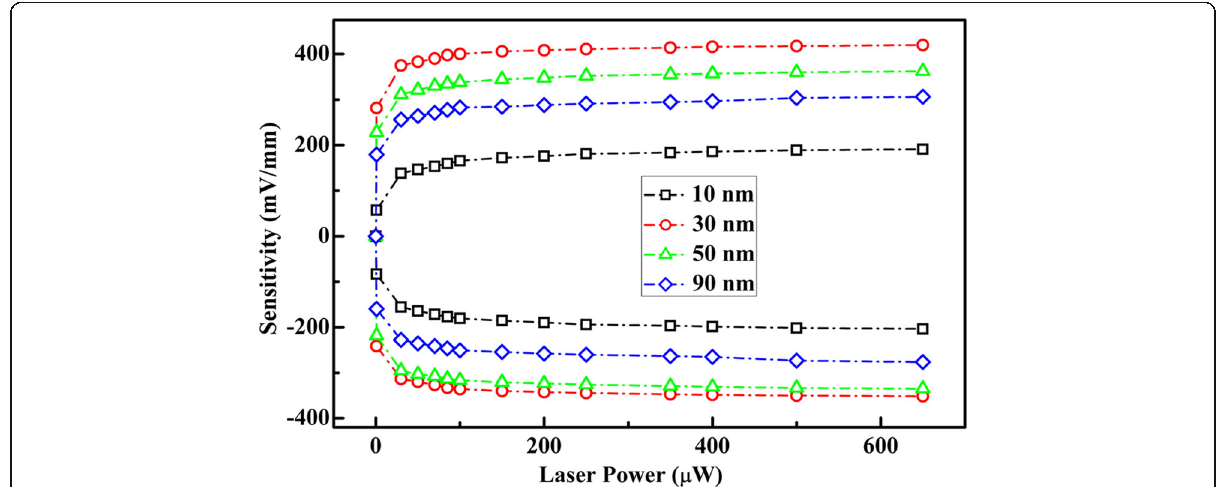
Fig. 5 Dependence of positive and negative sensitivities of the fabricated MoS 2 / n -GaAs heterojunction on laser powers,